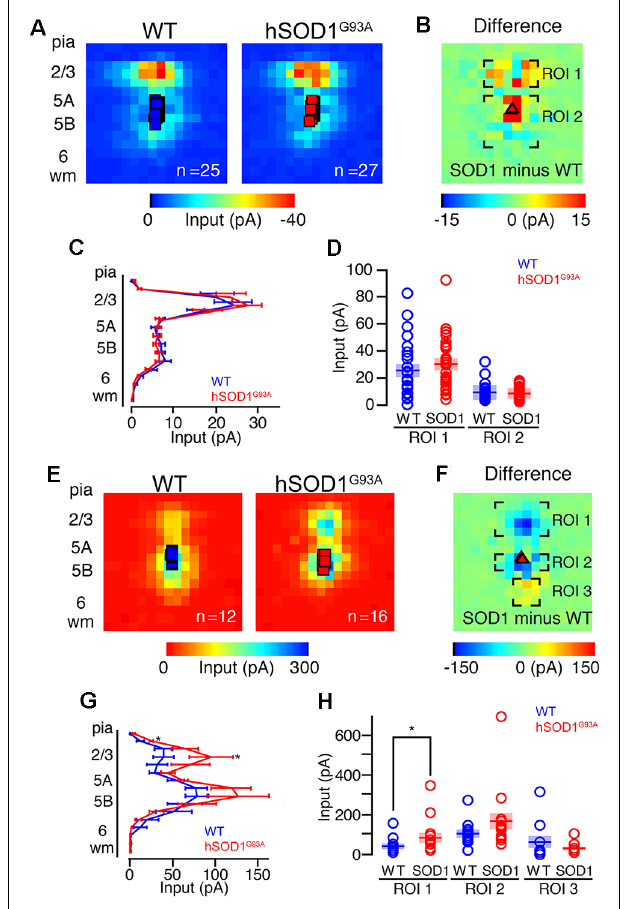
FIGURE 2 | Excitation and inhibitory profiles of CSMN in the motor cortex of WT and hSOD1 G93A mice at P30. (A) Examples of EPs for WT (left) and hSOD1 G93A (right) neurons with excitatory color maps. Voids represent areas of direct excitation on the recorded neuron. (B) Mapping grid (16 × 16) depicting areas of analysis; Region-of-interest = ROI. (C) Row average of excitatory inputs within the analysis region. (D) Comparison of presynaptic excitatory input region-of-interest for WT and hSOD1 G93A CSMN. (E) Example inhibitory input trace maps for WT (left) and hSOD1 G93A (right) CSMN. (F) Mapping grid (16 × 16) depicting areas of analysis. (G) Row average of inhibitory inputs within the analysis region. (H) Comparison of inhibitory input region-of-interest for WT and hSOD1 G93A CSMN. * p < 0.05, Kruskal–Wallis test.